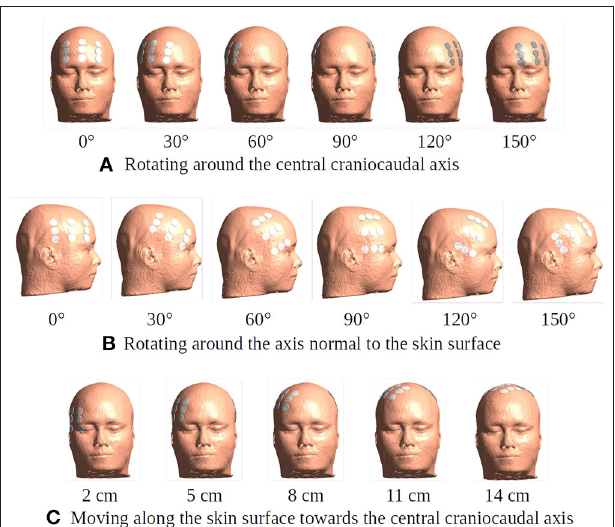
FIGURE 4 | Different placement of the transducer arrays. The electrode arrays are shown in white and gray color placed in the opposite positions over the head model. (A) Rotation of the array pair in 15-degree intervals around the central craniocaudal z -axis. The rotation plane is 5cm superior to the central horizontal plane. The subfigure illustrates six exemplary positions of degrees 0, 30, 60, 90, 120, and 150. (B) A 15-degree stepwise rotation of the ipsilateral array around the axis normal to the skin surface at the center of the array located above the resection cavity and residual tumor. The subfigure illustrates six exemplary positions of degrees 0, 30, 60, 90, 120, and 150. The contralateral array is maintained in the opposing position without rotation. The initial position is the same as the 60-degree one in (A) . (C) A 1-cm stepwise moving of the array pair along the skin surface toward the central craniocaudal axis. The starting position of the array pair is 3cm inferior to the 60-degree one in (A) . This corresponds to 2, 3, 4, 5, 6, 7, 8, 9, 10, 11, 12, 13, 14, and 15cm on the skin surface toward the central craniocaudal z -axis. The subfigure illustrates five exemplary